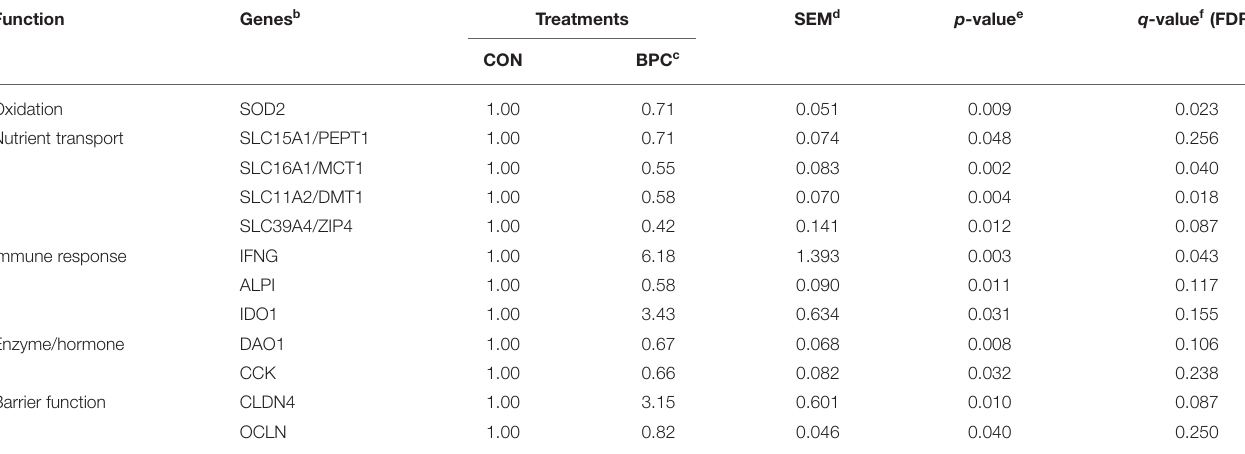
TABLE 3 | Effects of BPC supplementation during gestation of hyperprolific sows on related jejunal health-function mRNA relative expression of neonate piglets a . Function Genes b